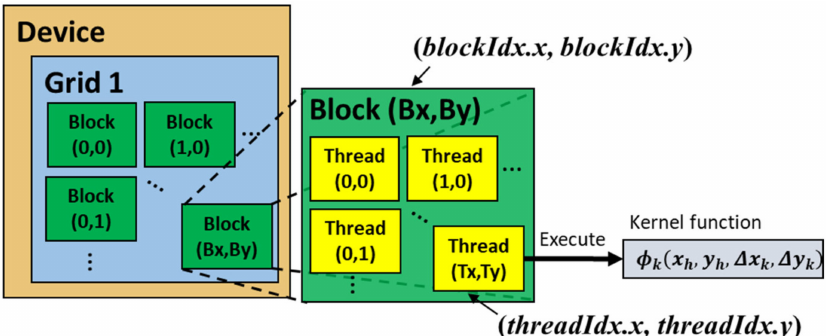
Figure 2. CUDA for CGH calculation. Each thread handles a pixel of a CGH, calculating the phase value using Equation (1) for single-beam steering, or Equation (4) for multi-beam steering. ∆ x k and ∆ y k are the lateral shift in x and y direction (Figure 1b),